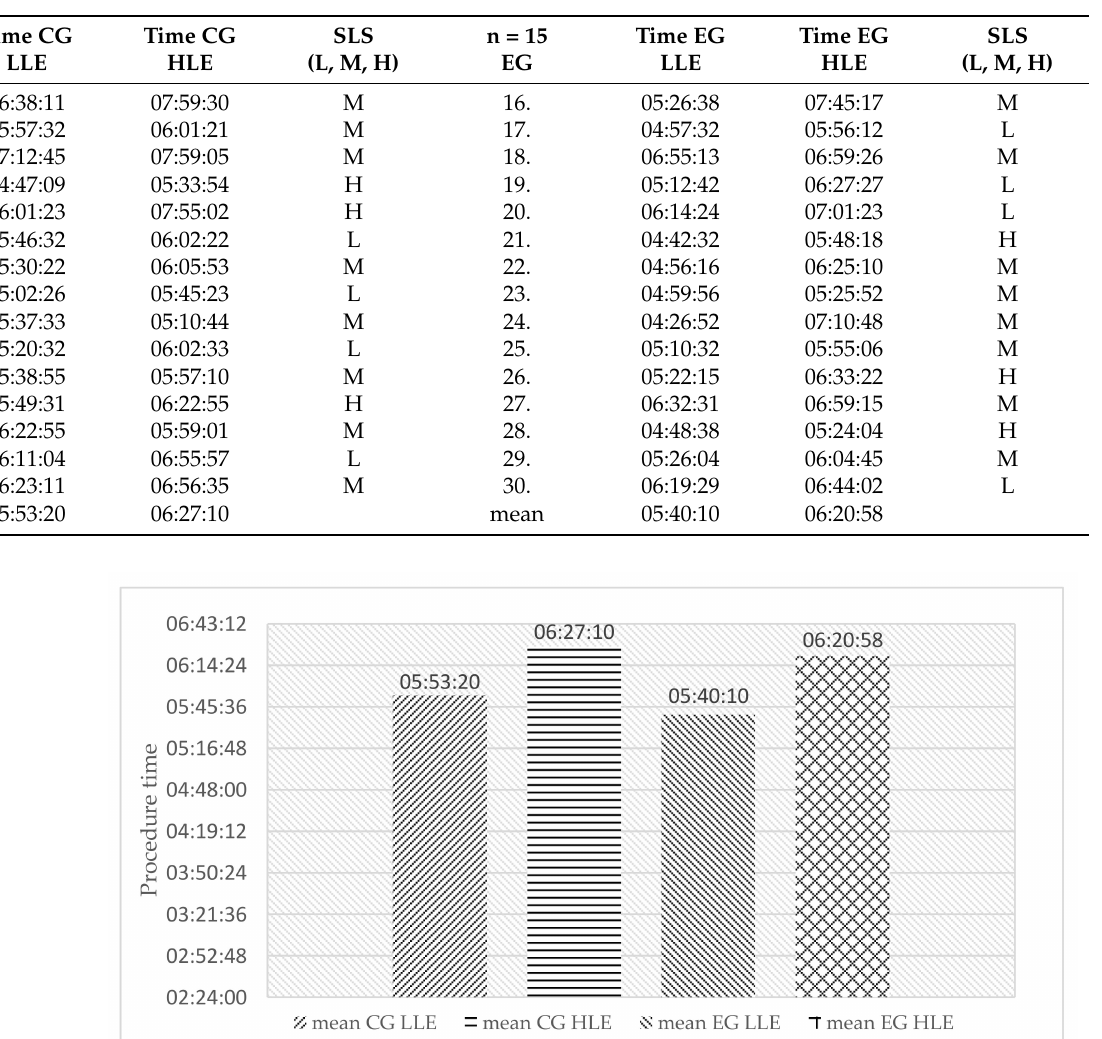
Table 6. Time procedure measurements of CG and EG, for LLE and HLE.